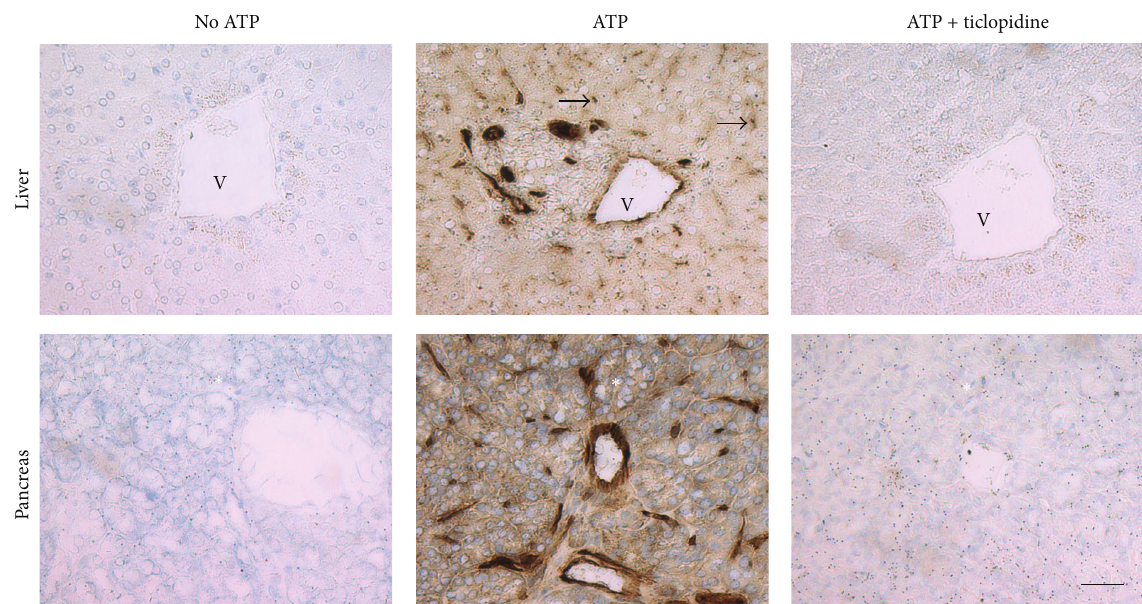
Figure 5: Inhibition of NTPDase1 ATPase activity in human tissues by ticlopidine. Enzyme histochemistry was performed on serial sections with the substrate ATP at a final concentration of 200 𝜇 M in the presence or absence of 100 𝜇 M ticlopidine. In both tissues (liver and pancreas) NTPDase1 ATPase activity is located in endothelial cells of all blood vessels including capillaries and sinusoids as well as in smooth muscle cells of arteries and in resident macrophages (K¨upffer cells in the liver). In addition, in the pancreas NTPDase1 is also expressed at the luminal surface of acinar cells and in zymogen granules. The ATPase activity is seen as a brown precipitate and is completely absent in presence of ticlopidine. Nuclei were counterstained with haematoxylin. Scale bar = 50 𝜇 m. V = vein; ∗ = Langerhans islet; arrows = K¨upffer